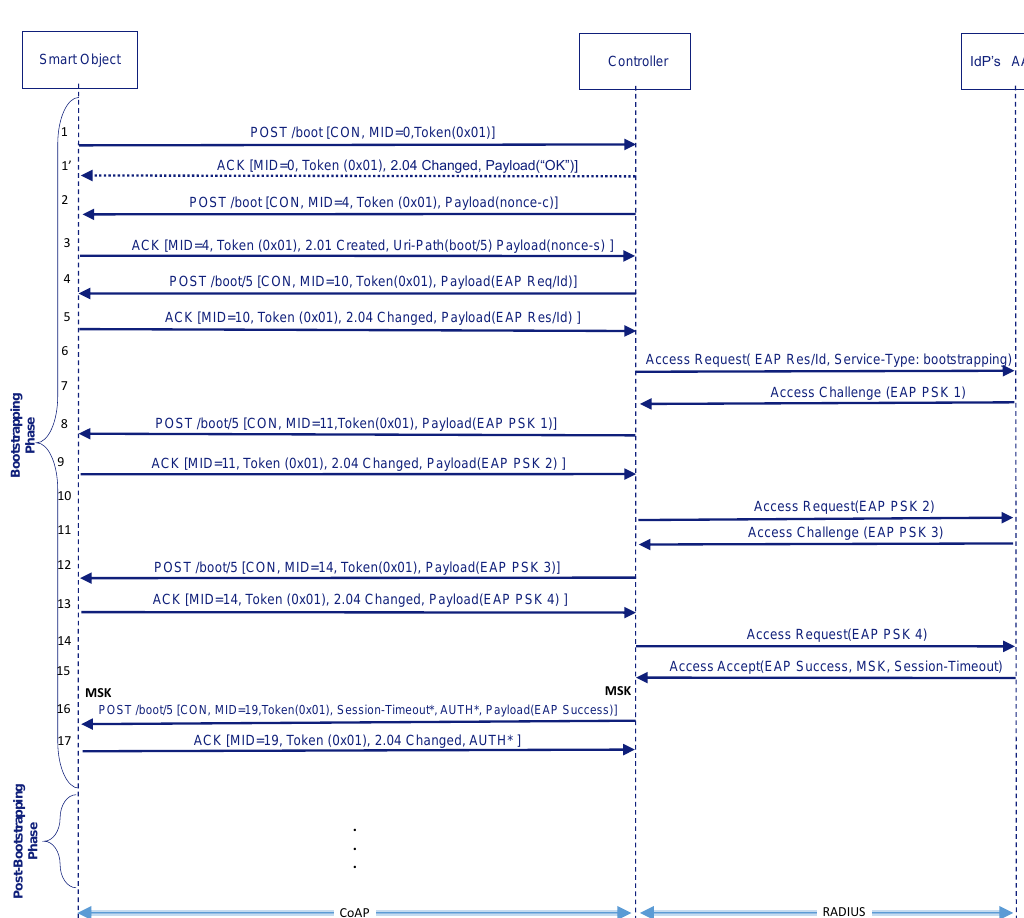
Figure 4. CoAP-EAP bootstrapping service flow (using EAP-pre-shared key (PSK) as example of EAP